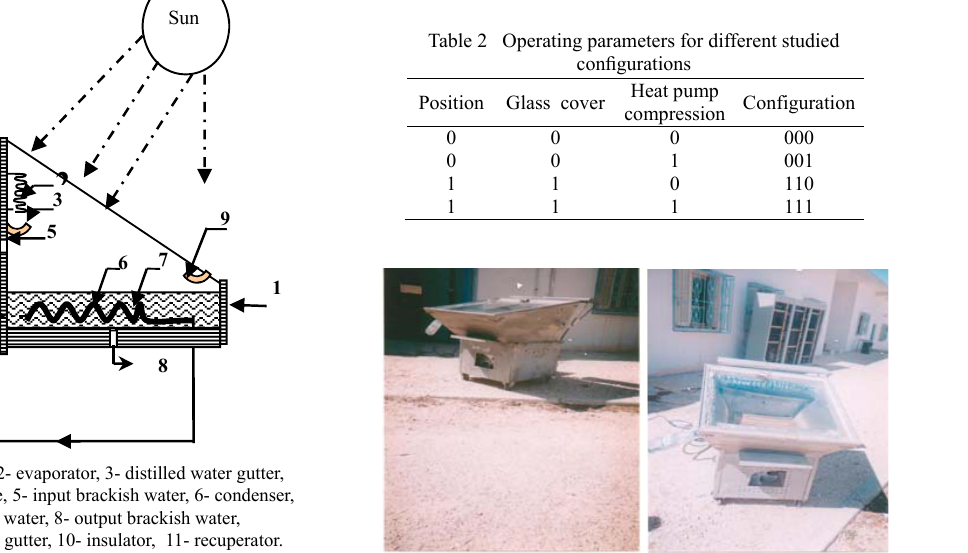
Fig. 3. Photograph of the SSD and Fig.3: Photograph of the SSD and SSDHP still